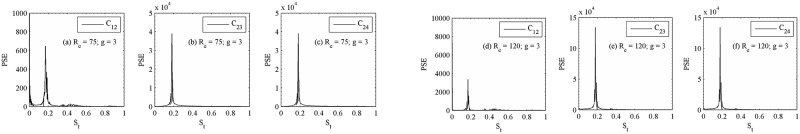
Spectra analysis of lift coefficients at (a-c) (Re, g) = (75, 3) and (d-f) (Re, g) = (120, 3).